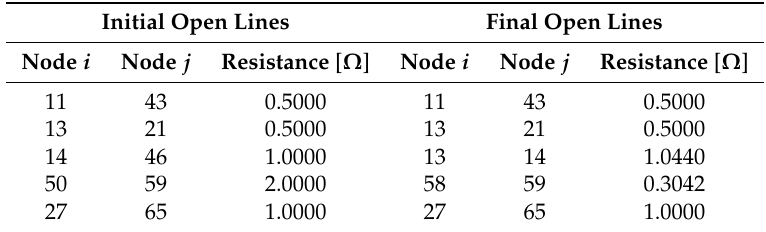
Table 8. Initial and final configurations for the 69-node test feeder. Initial Open Lines Final Open